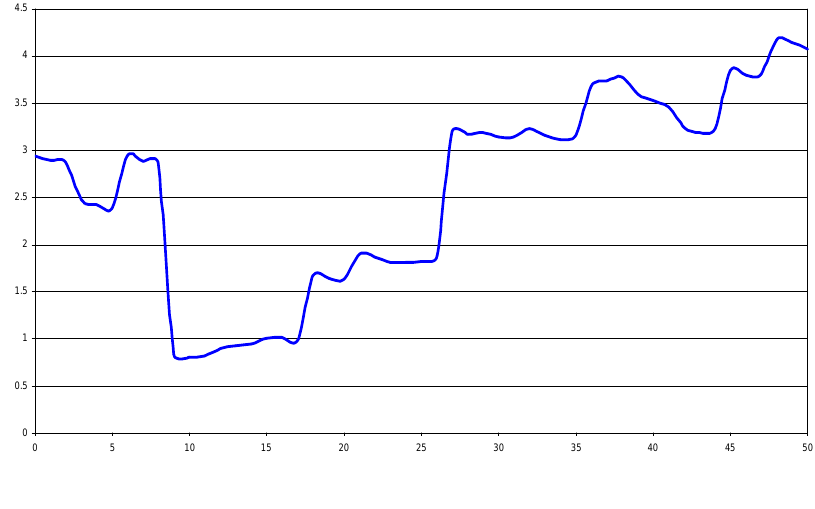
Figure 6. Dynamics of the financial stability index of PJSC Sberbank